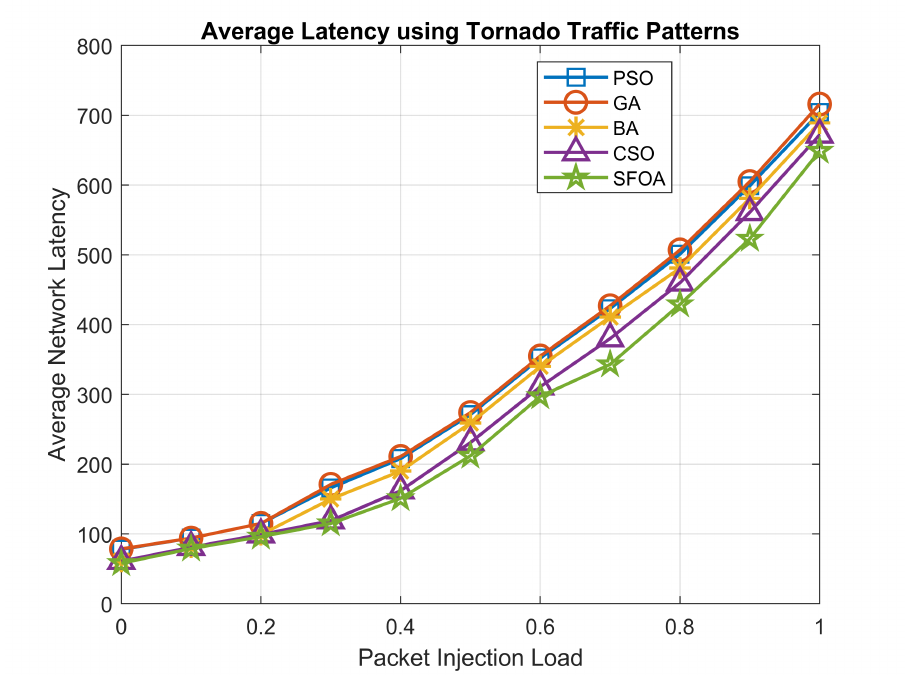
Figure 8. Average network latency for Tornado traffic